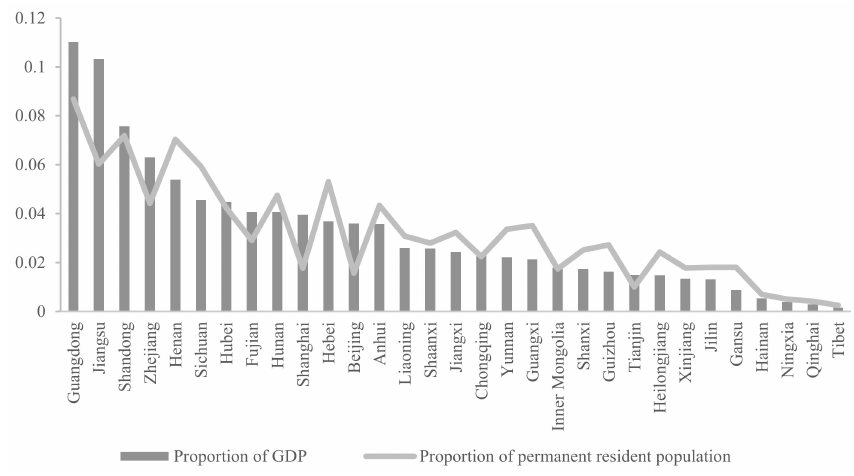
Figure 1. The proportion of GDP and permanent resident population in 2017 in Chinese provinces (data source: National Bureau of Statistics of China).